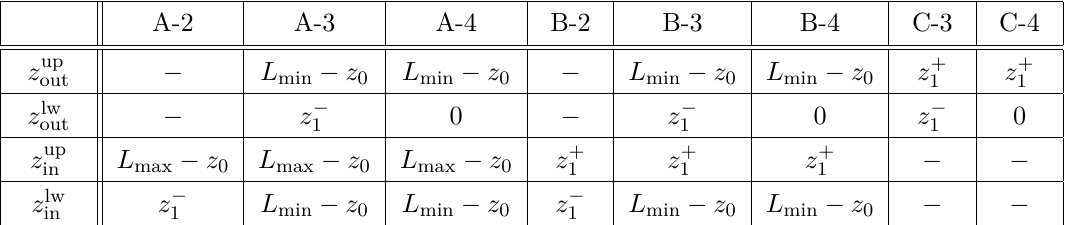
are defined in eqs. (A.12). The 1